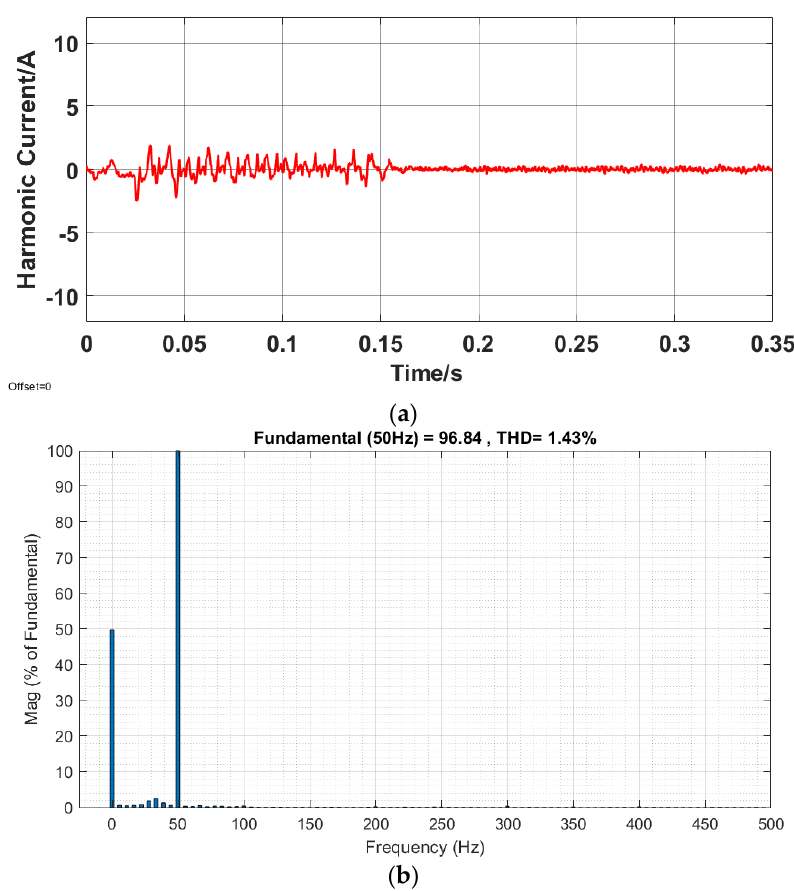
Figure 14. ( a ) Harmonic current with the PIR virtual impedance composite suppressor. ( b ) FFT analysis of the bridge arm current with the PIR virtual impedance composite suppressor.